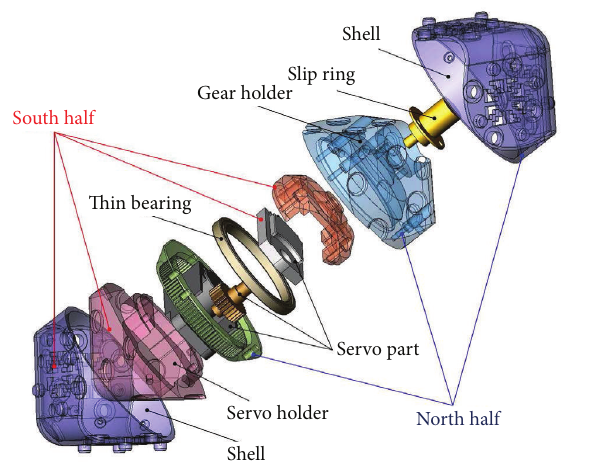
Figure 5: The structure of Molecube